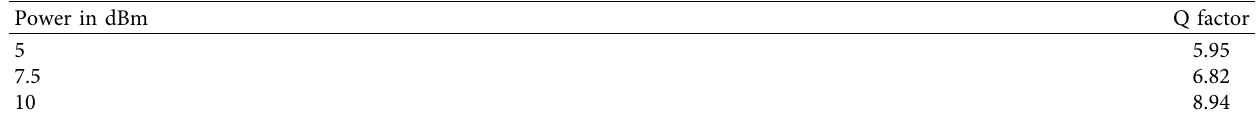
Table 2: Q factor versus CW laser power for [15].